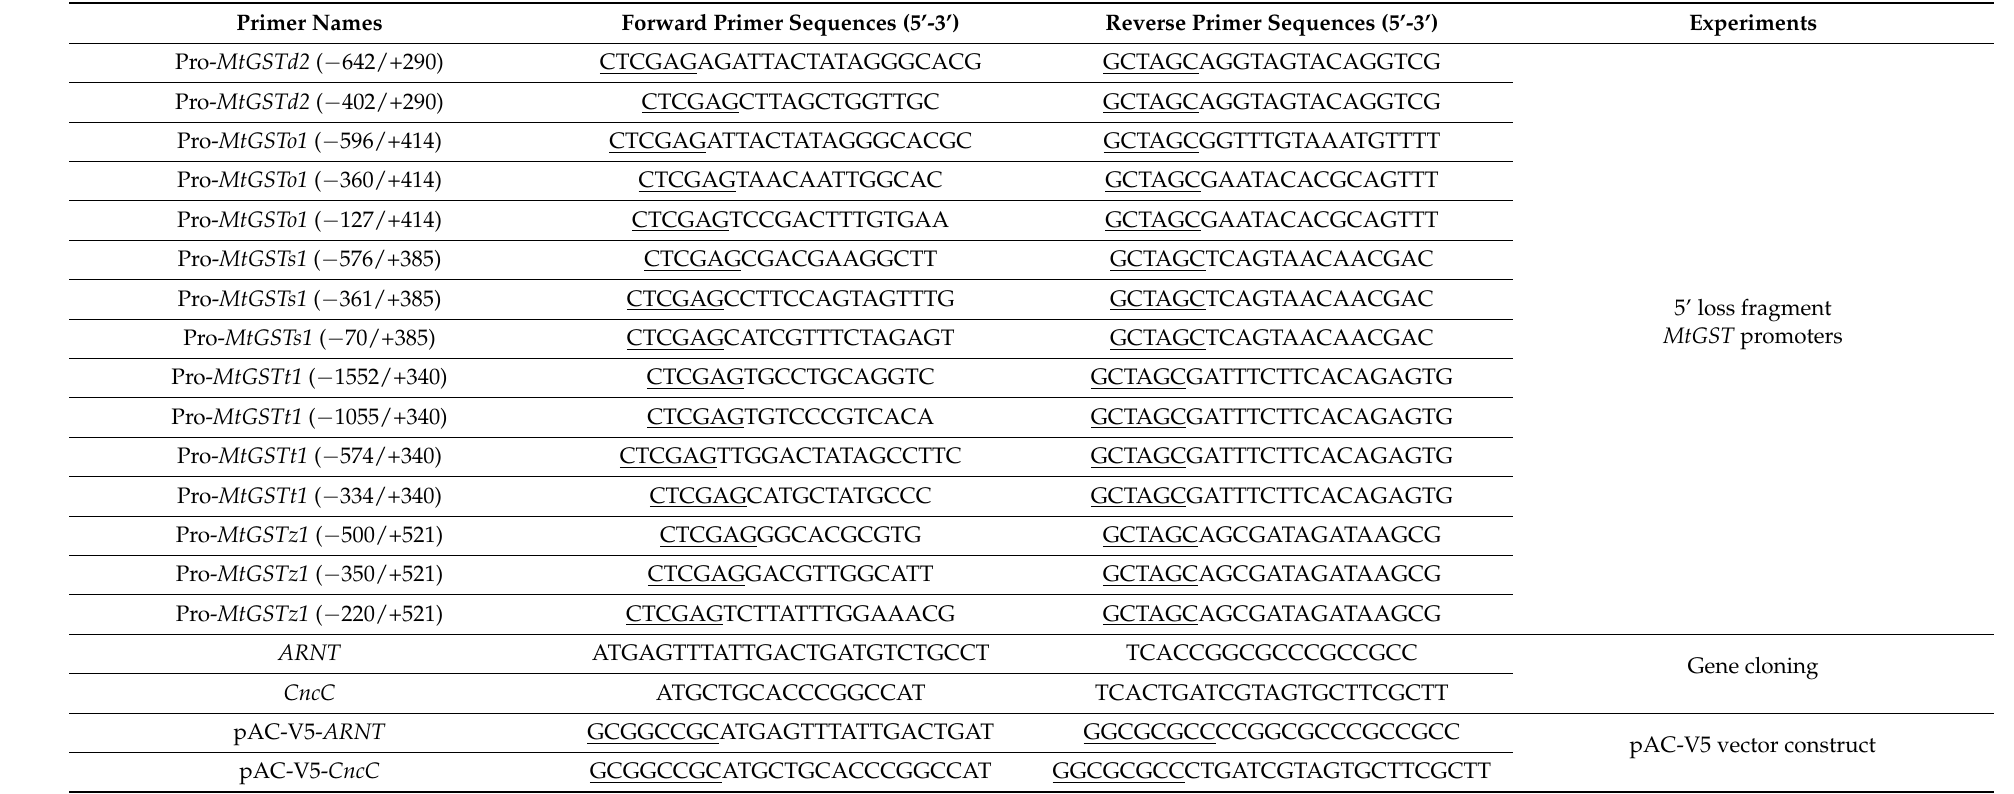
Table 1. The primers used for this